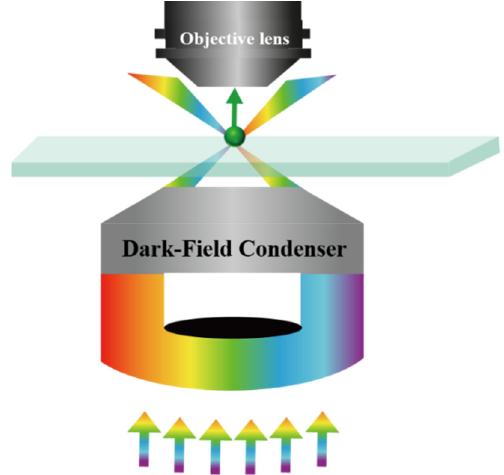
Figure 1. Schematic of the typical optical path of the DFM with the dark-field condenser.